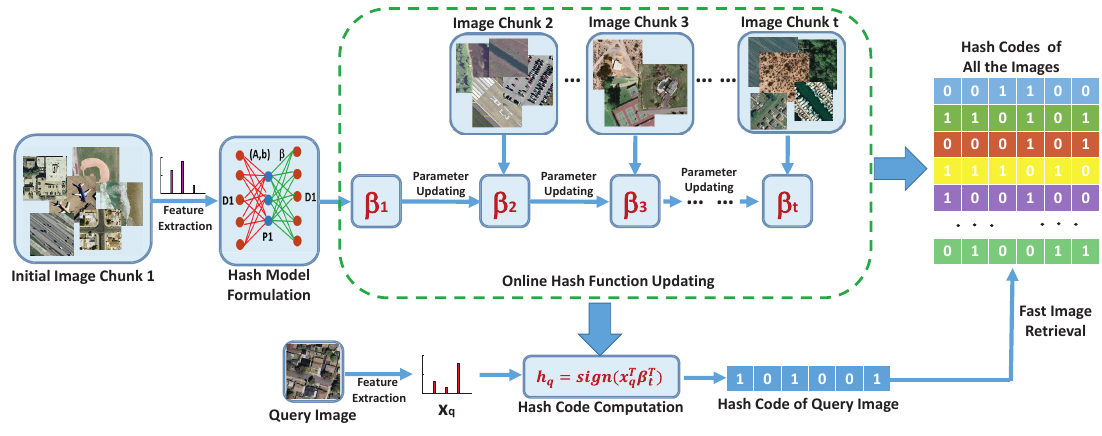
Figure 1. The illustration of the proposed online hashing approach for scalable remote sensing image